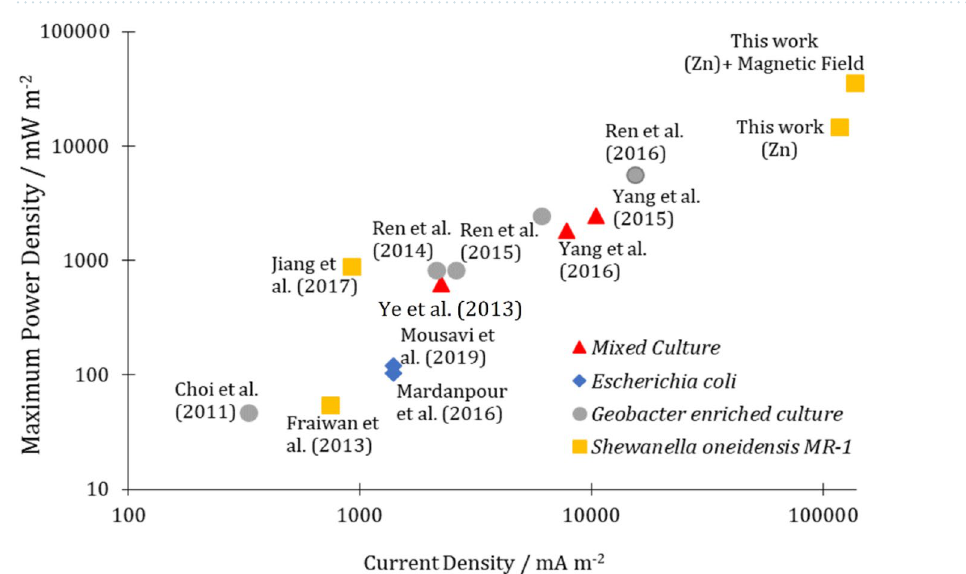
Figure 8. The performance of the Zn-anode microfluidic MFC inoculated with Shewanella oneidensis MR-1 compared to previously published